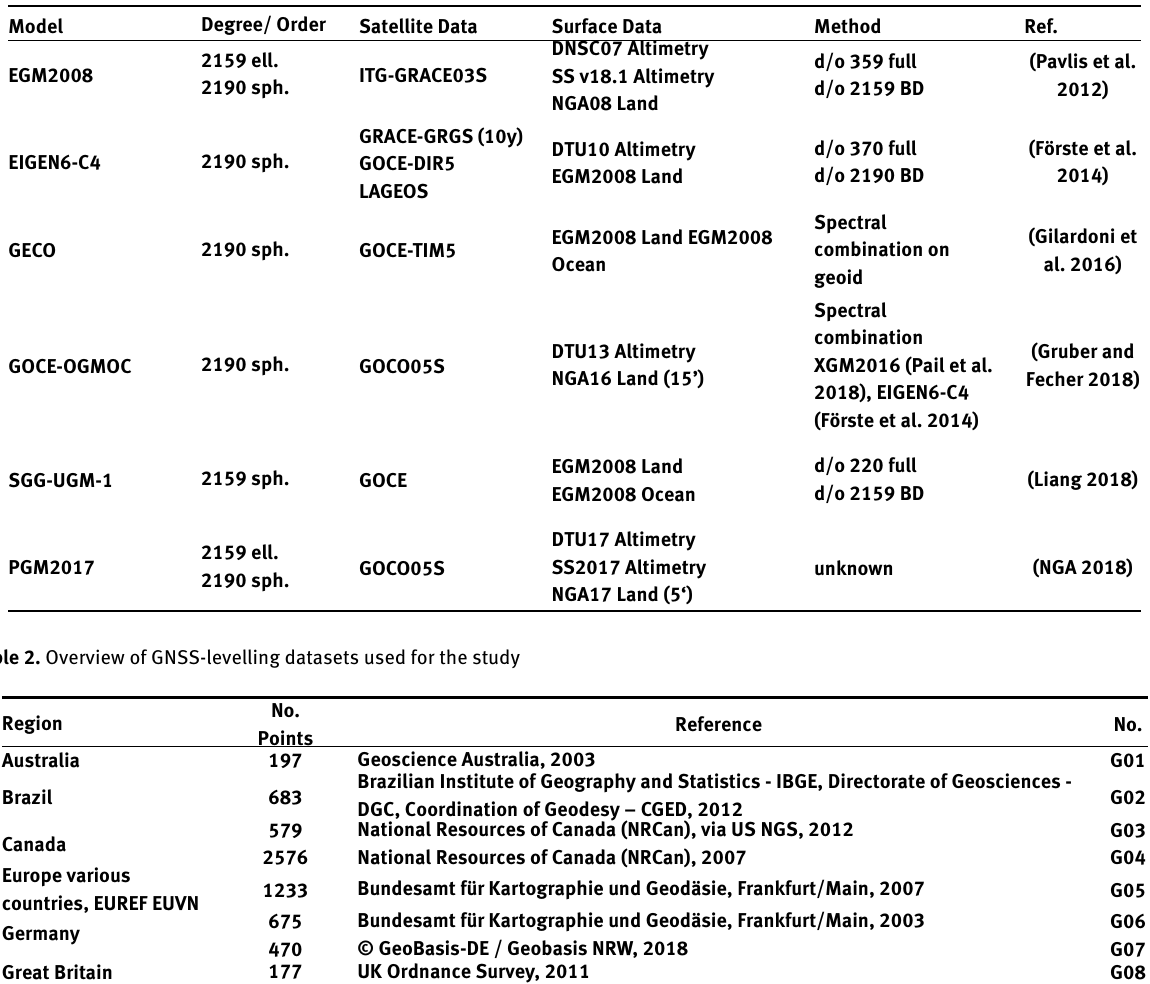
Table 1. Overview of high resolution global gravity field models. Degree/Order: maximum resolution of the model in the spectral domain (sph. = spherical domain, ell. = ellipsoidal domain); Satellite Data: satellite data applied in the model; Surface Data: altimetric and land data sets used in the model; Method: combination method, full = usage of full normal equations, BD = block-diagonal normal equations, Spectral combination = combination of models.